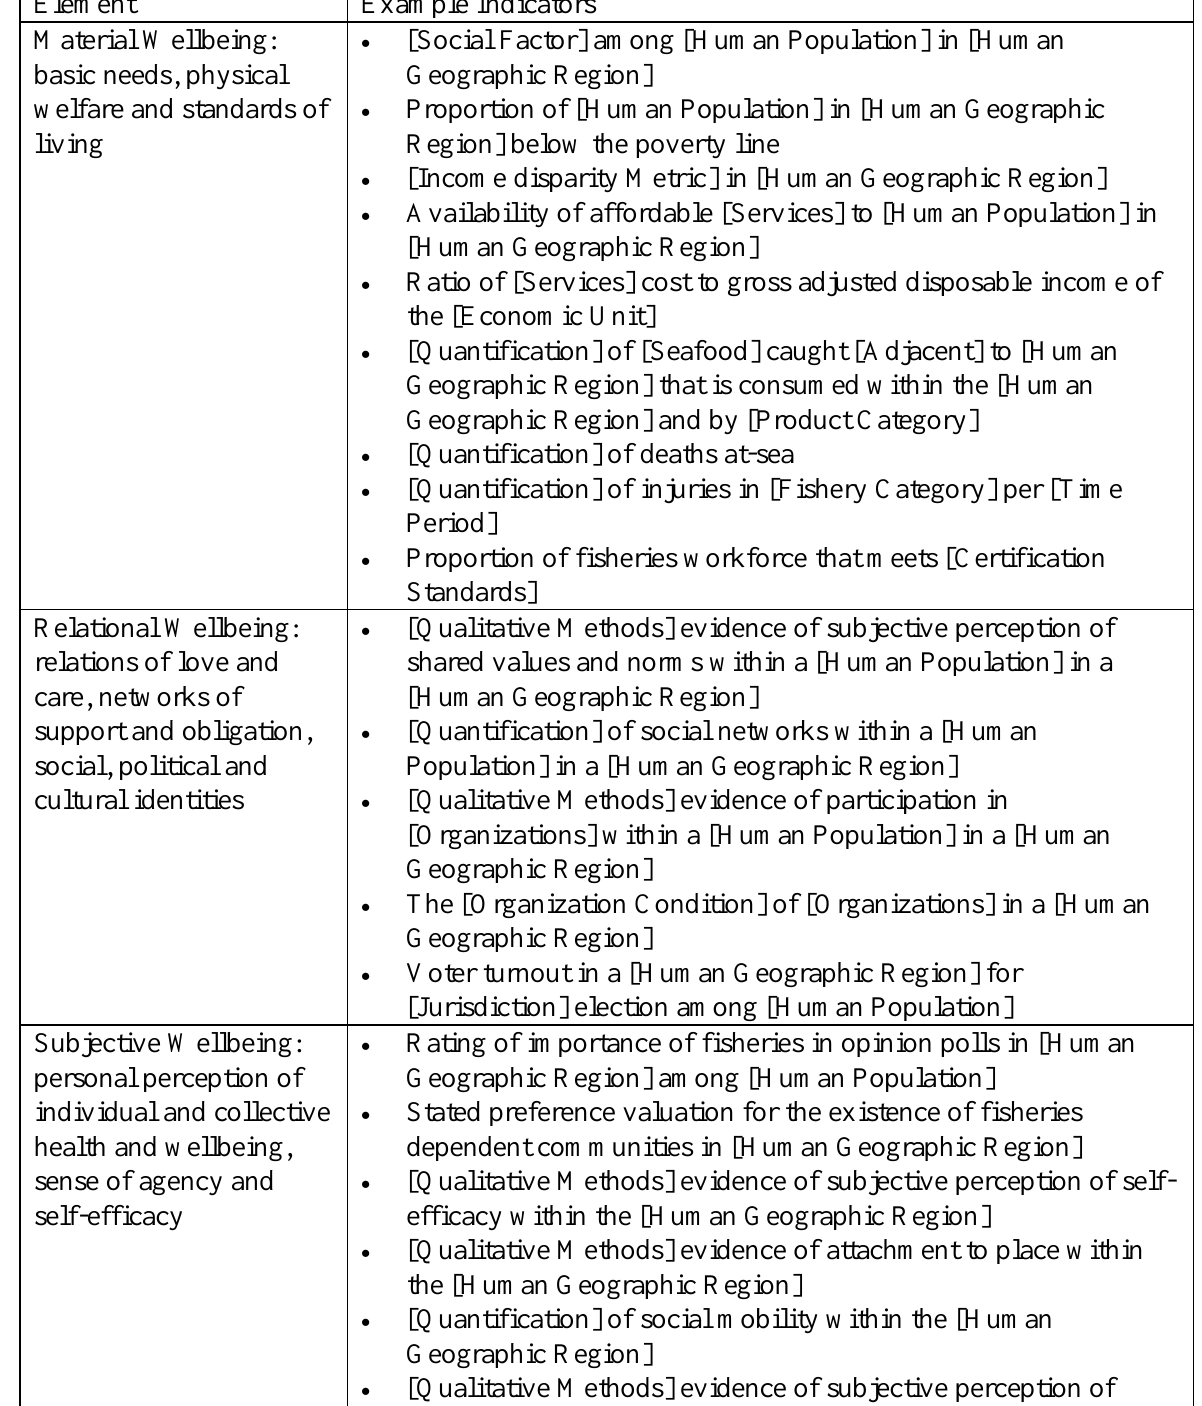
Table A1.7: Health & Wellbeing Dimension – Example Indicators Element Example